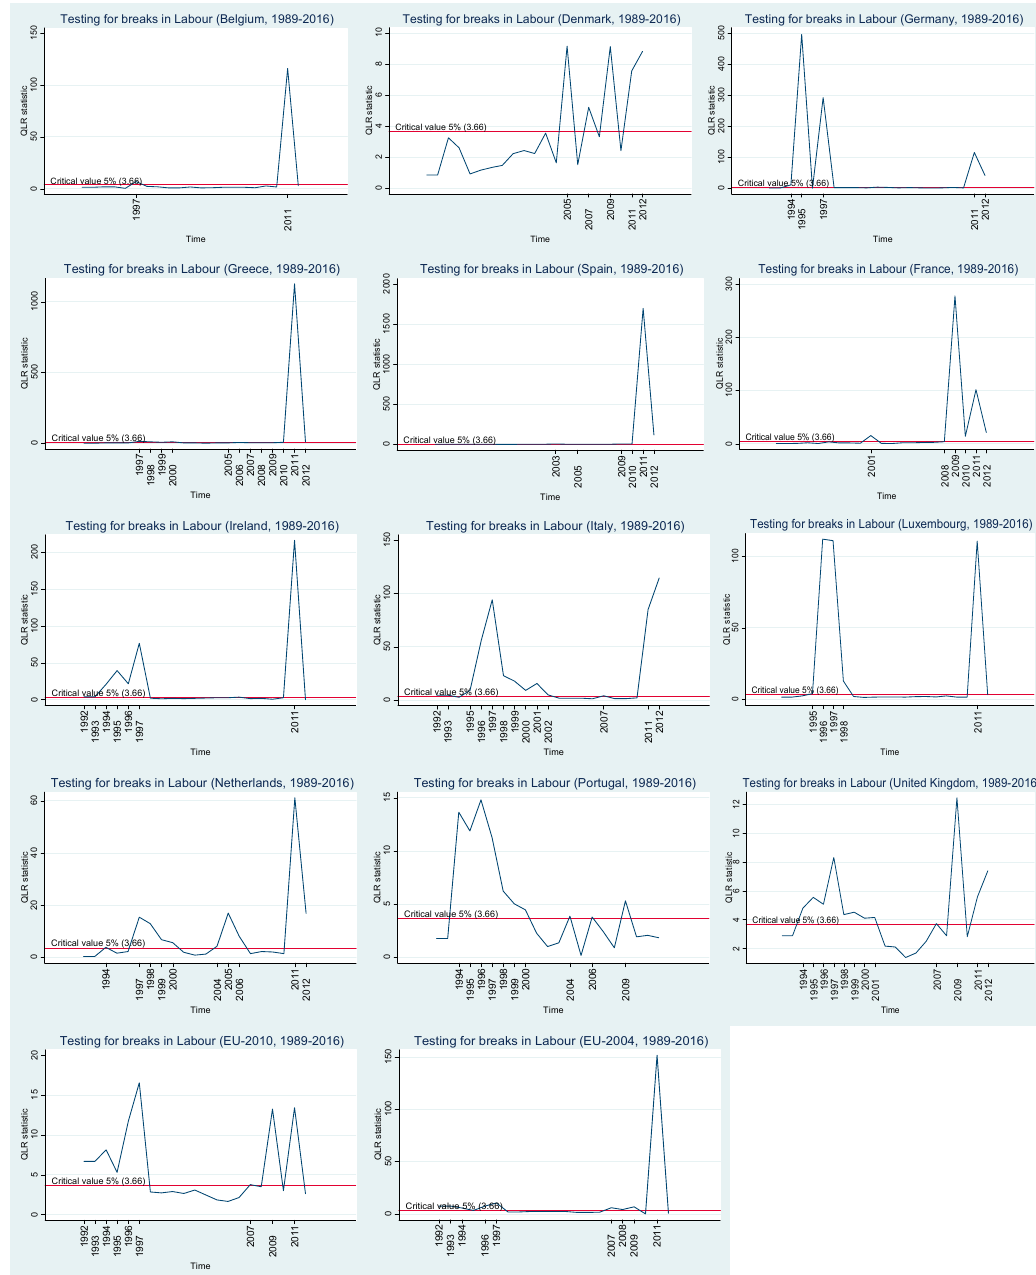
Figure 2. Testing for breaks in labour (hours) over the European Union countries